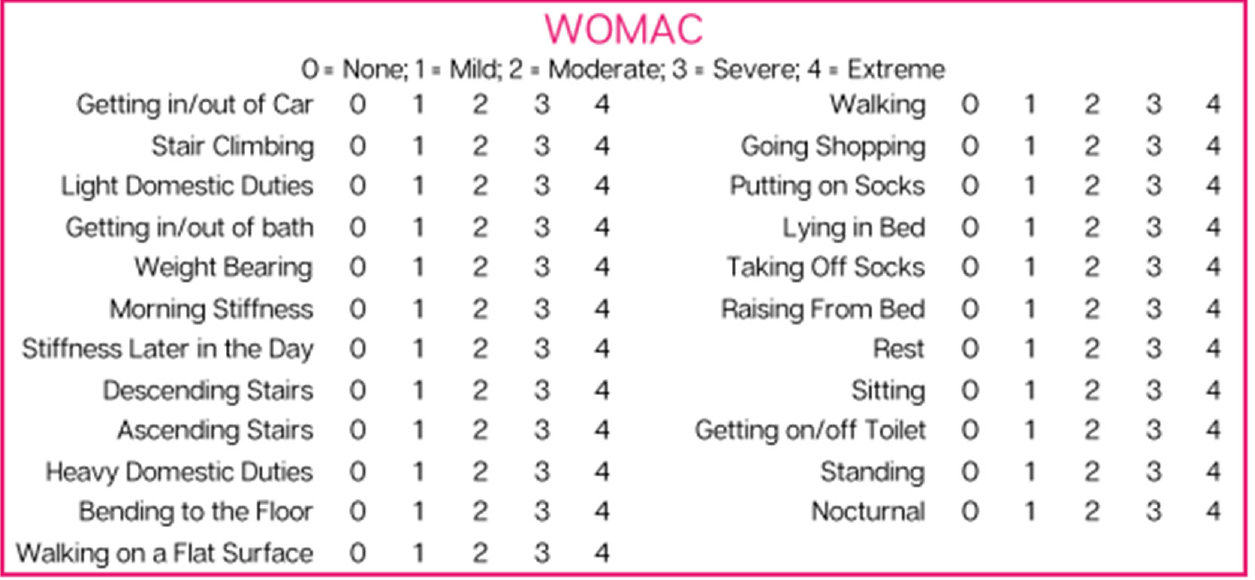
Figure 2. Western Ontario and McMaster Universities Arthritis Index used by patients to assess pain, stiffness, and function.